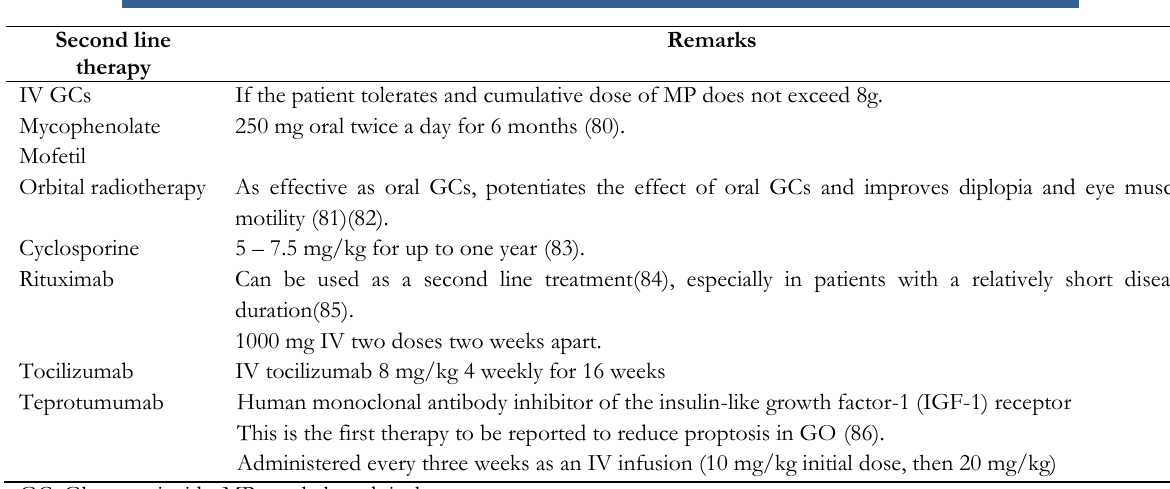
Table 3.17. Second line treatment of moderate-severe and active